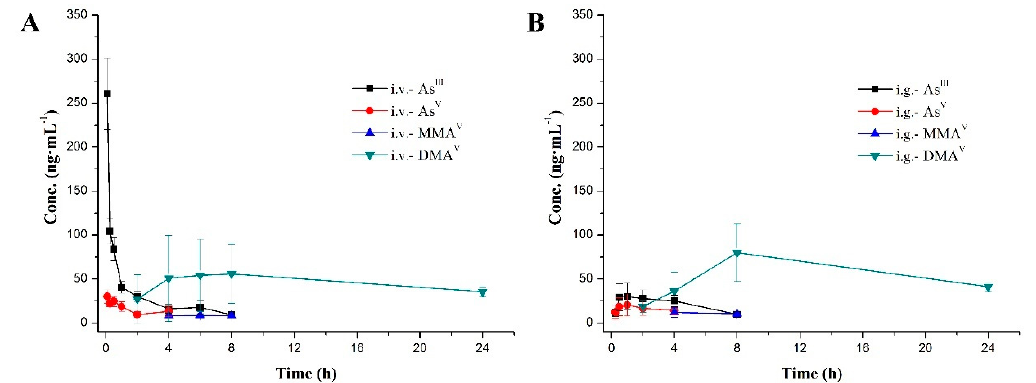
Figure 3. Mean plasma concentration-time curves of the four arsenic species after administration ( A . intravenous; B . intragastrical) at a single dose of 0.80 mg · kg − 1 (0.61 mg · kg − 1 of arsenic). Data are mean ± SD ( n = 10).